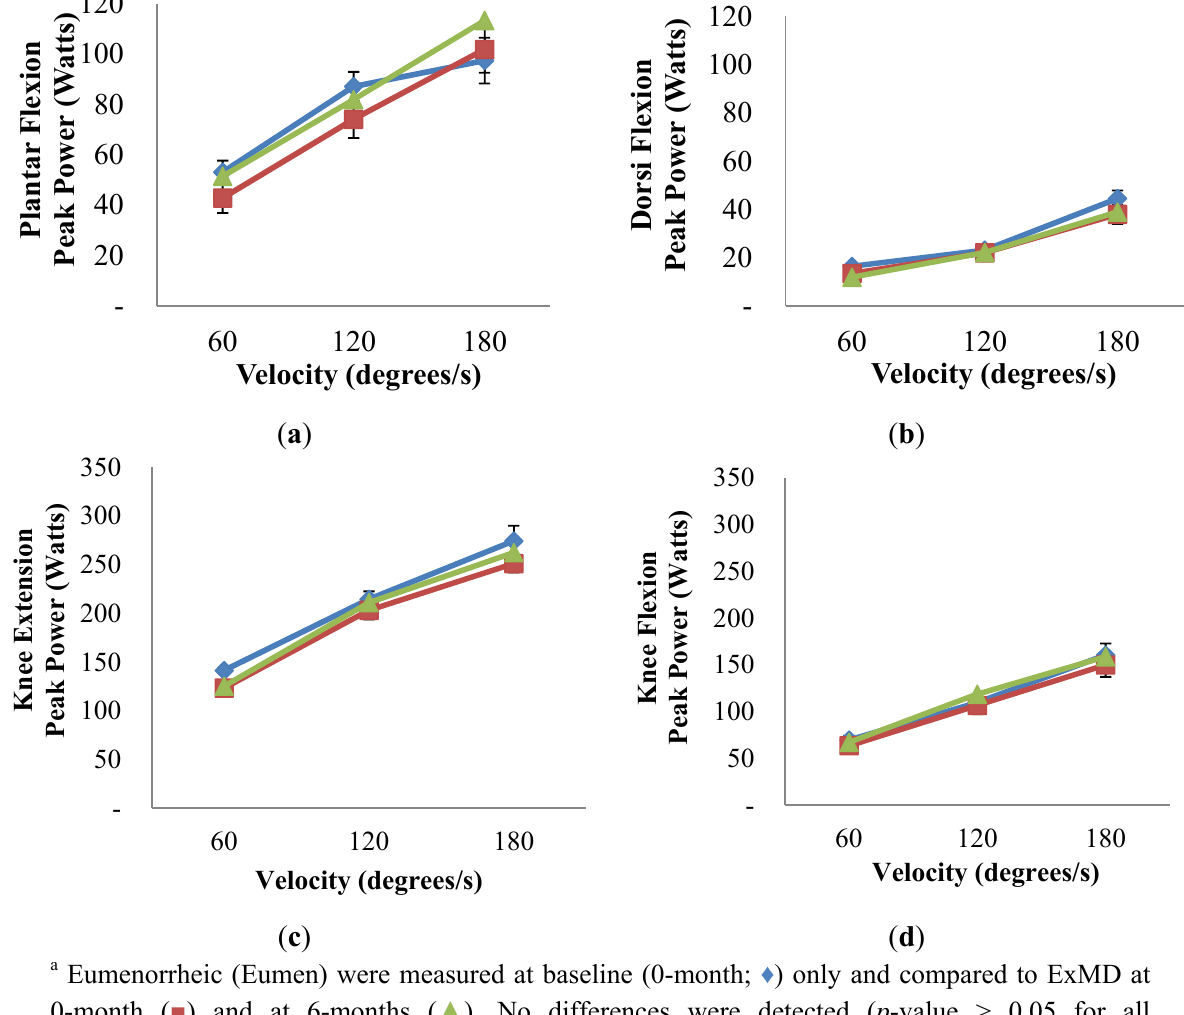
Figure 2. Peak Power for plantar flexion ( i.e. , ankle extension) ( a ); dorsi flexion ( i.e. , ankle flexion) ( b ); knee flexion ( c ); and knee extension ( d ) during isokinentic contractions in Eumenorrheic and ExMD women at pre/post-intervention a